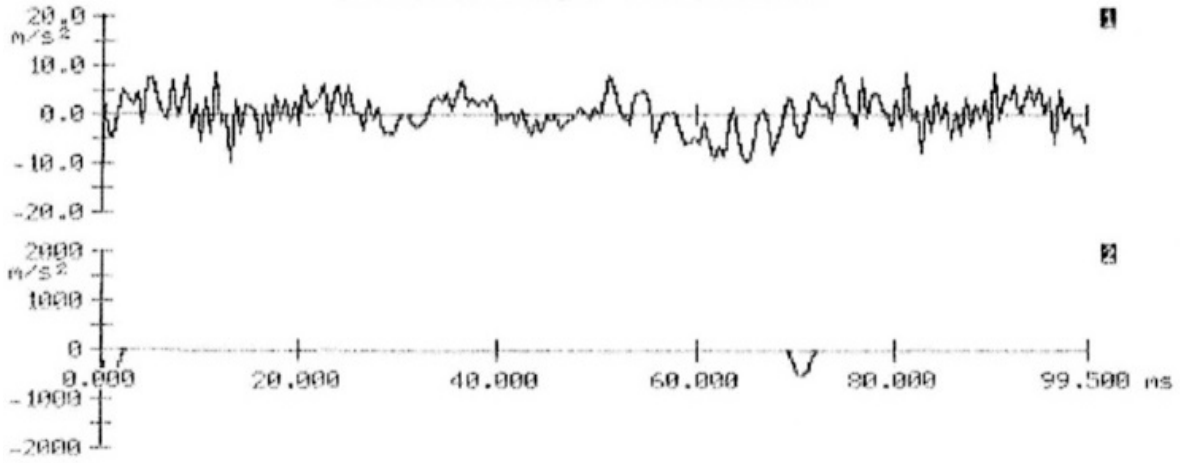
Figure 10. Synchronously averaged waveform of compressor torsional vibration acceleration: high pass filter—1 Hz; low pass filter—1 kHz; 16 averages.